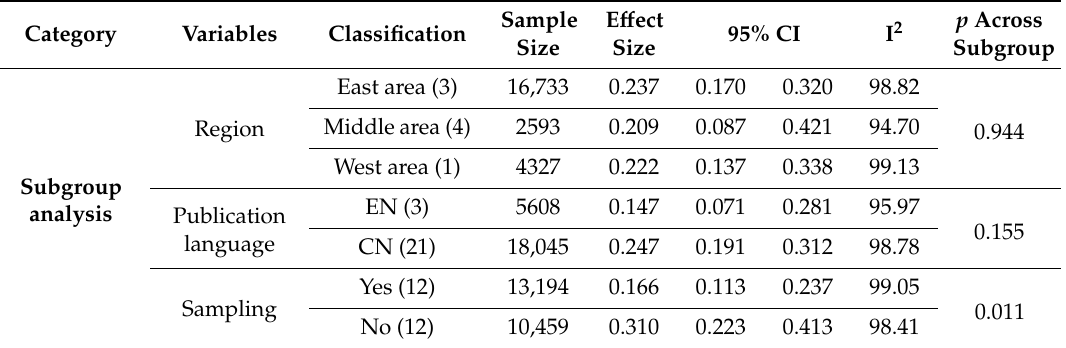
Table 3. Meta-regression analyses.